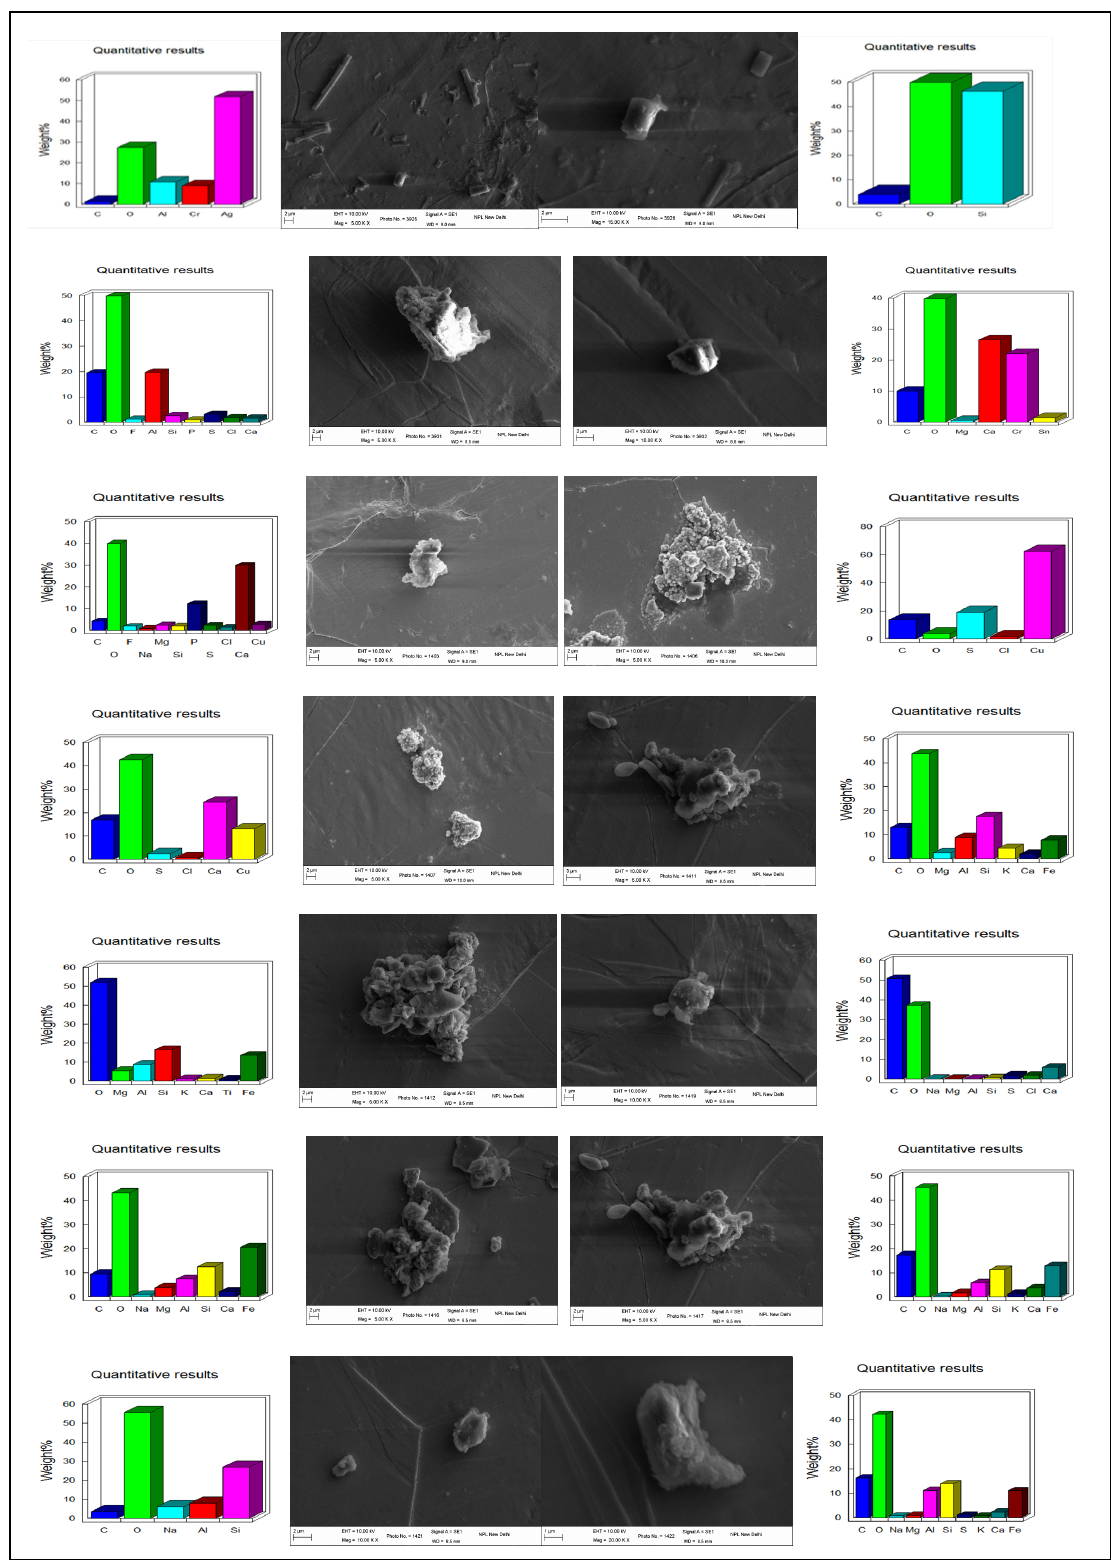
Figure 5. Morphology and chemical composition of individual particles during Smog